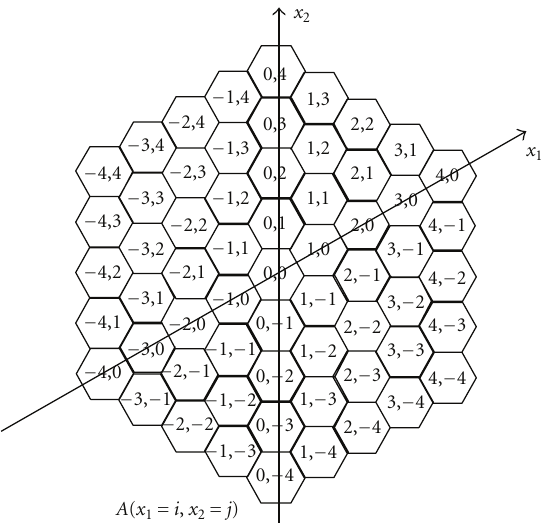
Figure 1: Absolute Geographical Location Model: A ( x 1; x 2)